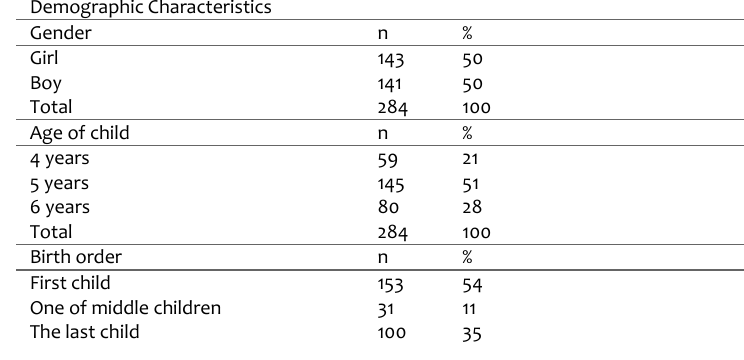
Table 1. Distribution of the Children Participating in the Study According to their Demographic